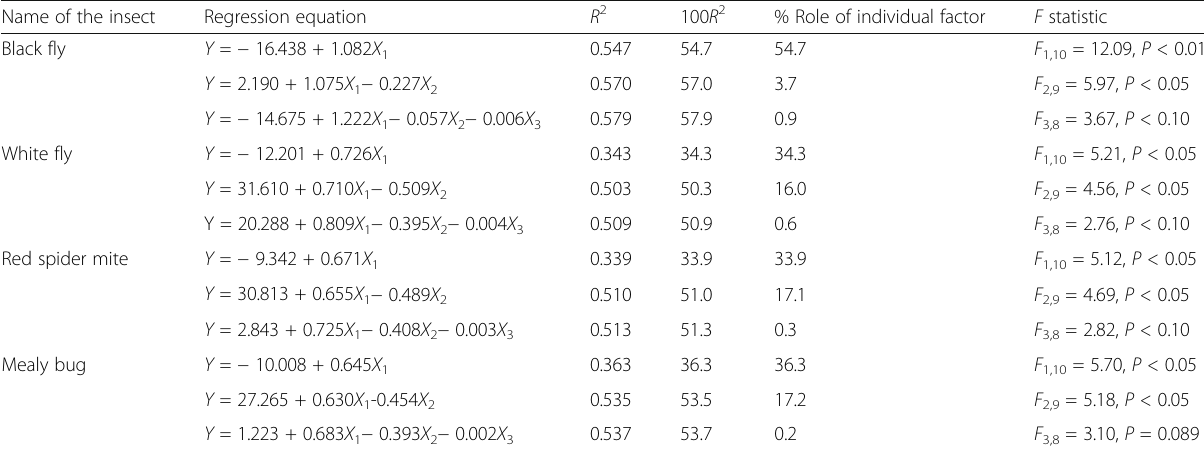
Table 2 Multiple linear regression models along with coefficients of determination ( R 2 ) regarding the impact of weather parameters on the seasonal abundance of different insect pests of betel leaf Name of the insect